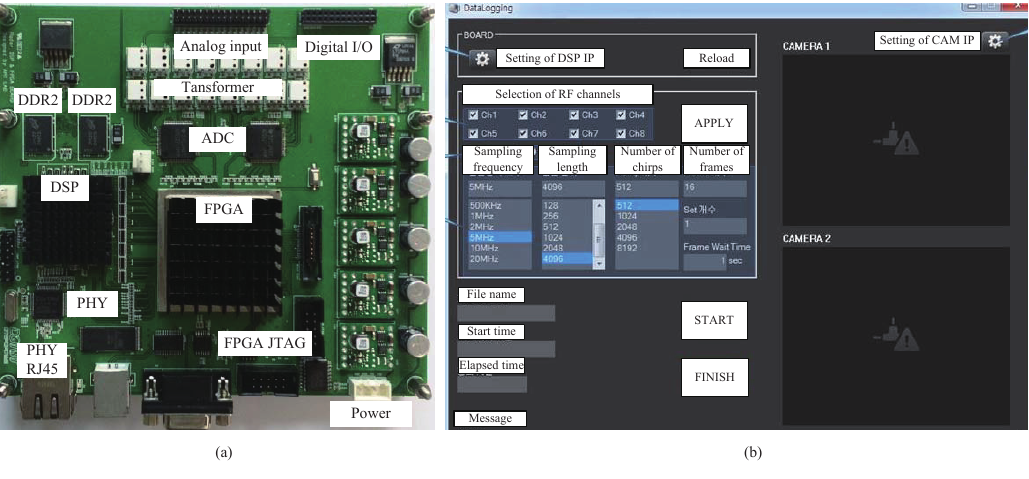
Figure 15. Back-end module (BEM) system for experiment; ( a ) data logging board; ( b ) graphic user interface